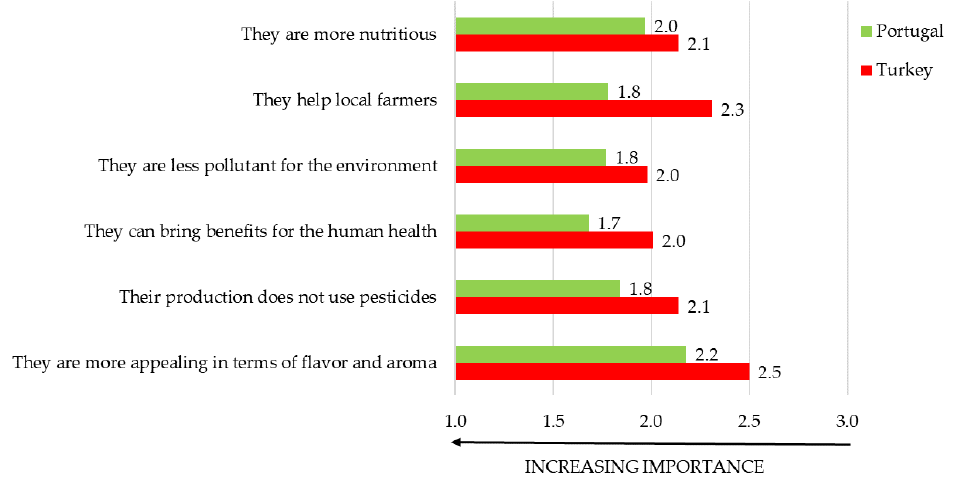
Figure 2. Average score for the reasons that motivate the participants to consume organic foods.